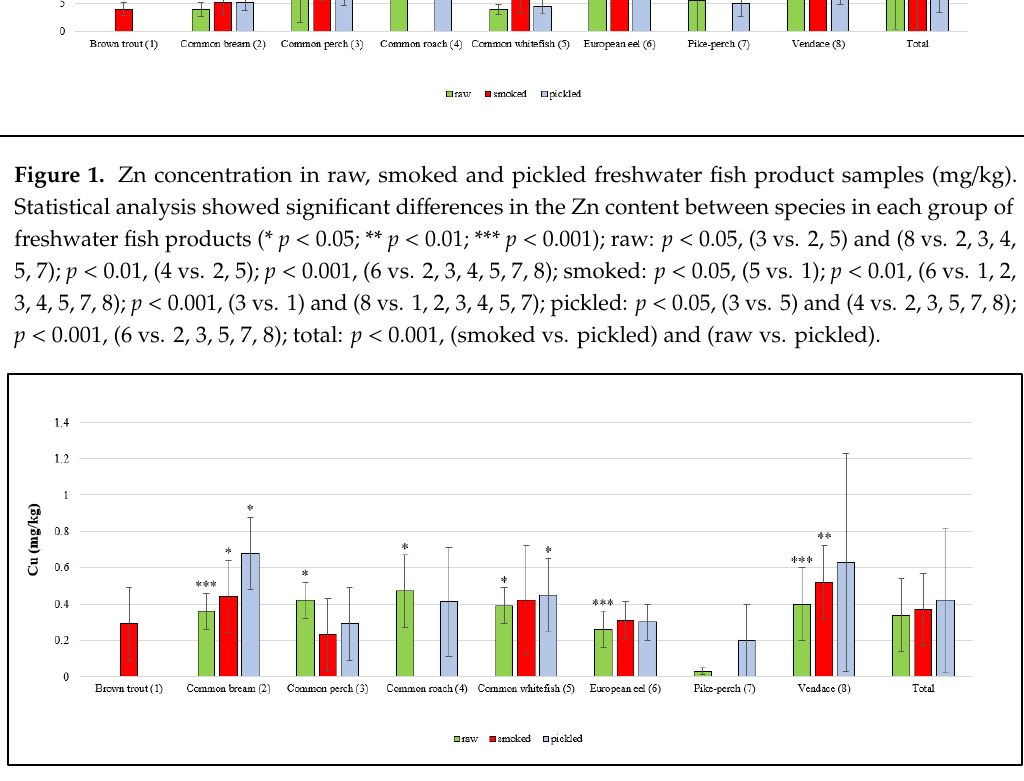
Figure 2. Cu concentration in raw, smoked and pickled freshwater fish product samples (mg/kg).